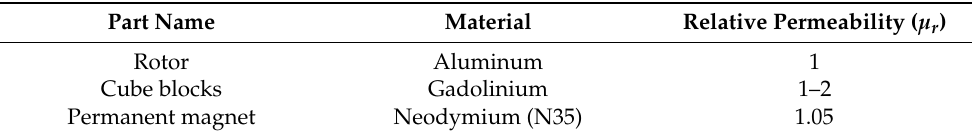
Table 1. Magnetic properties of different materials used in the thermomagnetic heat engine.